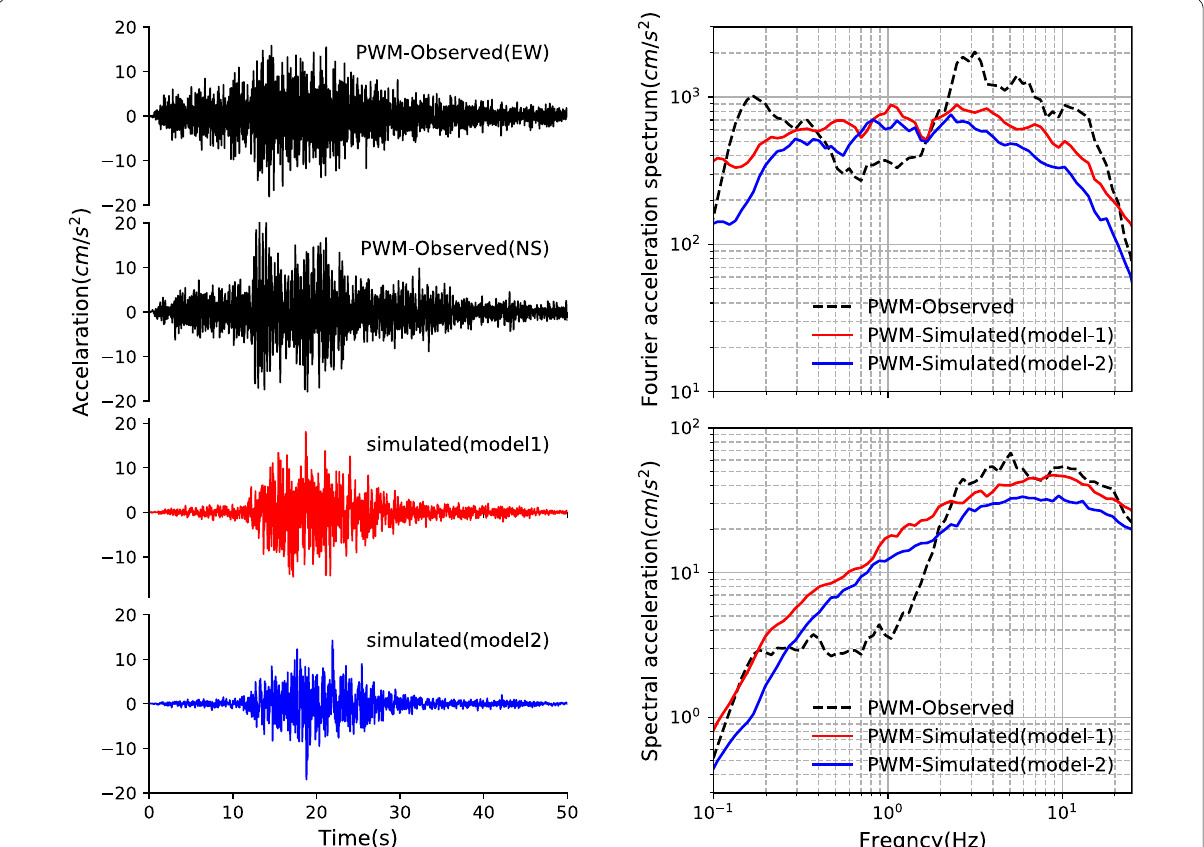
Fig. 5 Comparison of simulated and observed horizontal strong motions at PWM station. The observed (dashed lines) and simulated (solid lines) Fourier amplitude spectra and the response spectra of acceleration are also